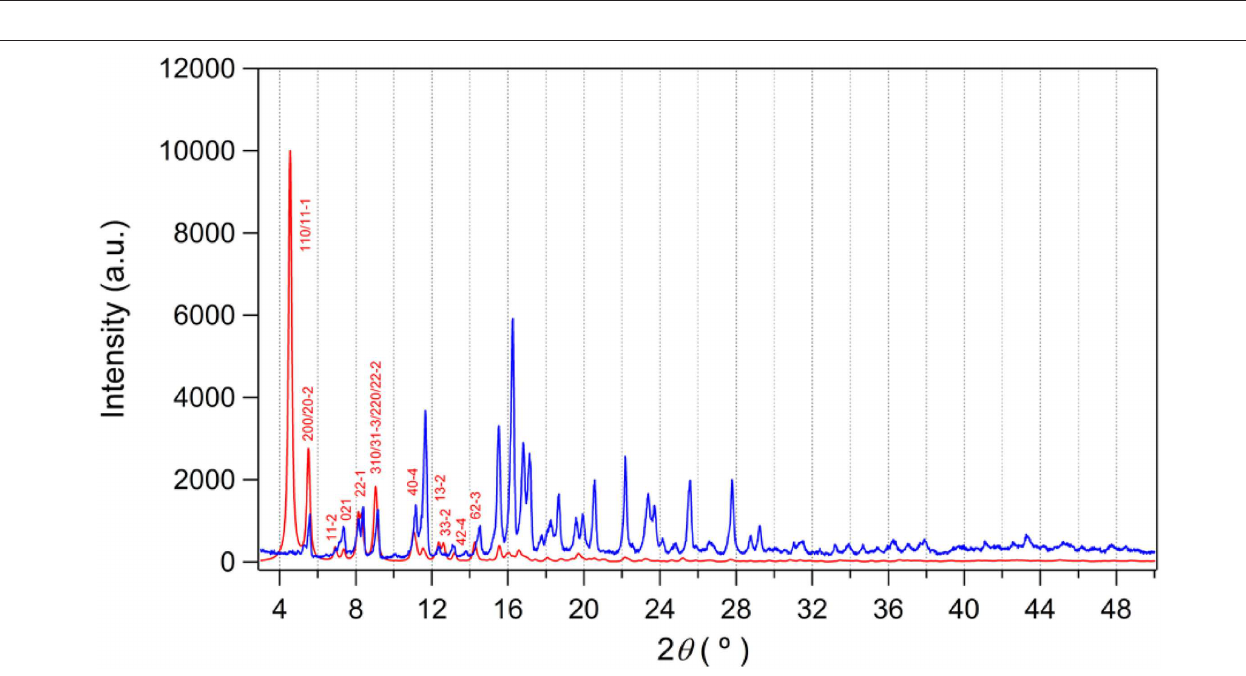
the permanent porosity of solvent-free I was evaluated by